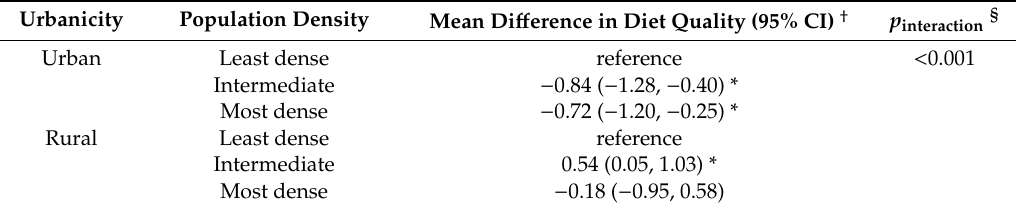
Table 6. Mean di ff erence in diet quality (95% CIs) among participants living in more densely populated areas versus the least populated areas, results from adjusted LMMs stratified by